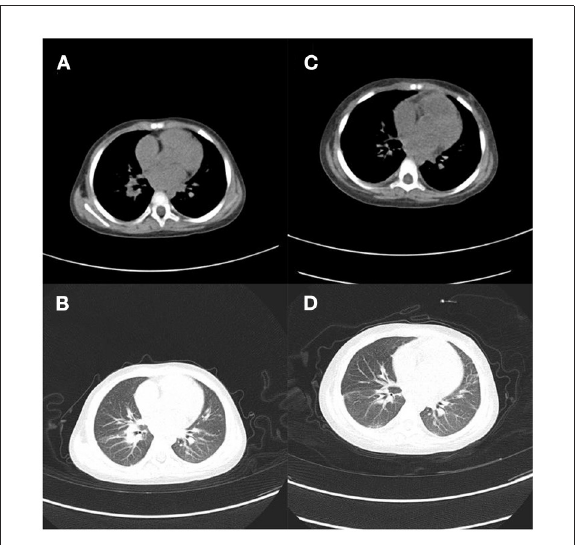
FIGURE5 Case 3. (A,B) Lung CT on day 1 showed mild lung infection, multiple nodules and thickening of the anterior mediastinal soft tissue; (C,D) Chest CT showed worsened infection in both lungs, multiple small nodules, and new bilateral pleural effusion 2 months